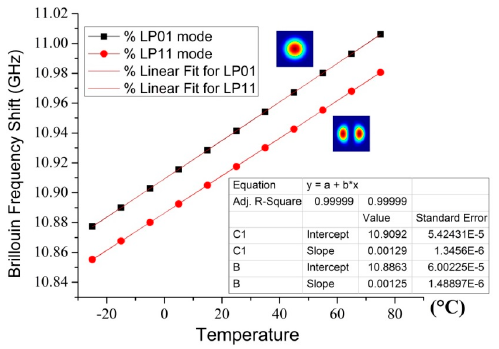
Figure 12. Calibration of temperature coefficients for different modes in FMF.